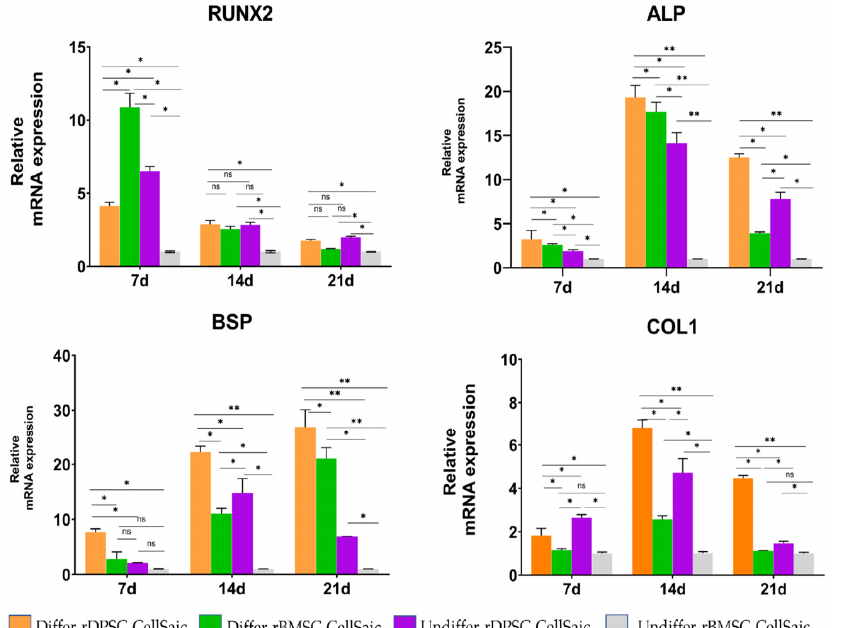
Figure 9. Expression of genes related to bone formation of rBMSC-CellSaic and rDPSC-CellSaic after culturing in normal and osteogenic differentiation media for 7, 14, and 21 days. Differ-rD-CellSaic and Differ-rB-CellSaic were osteogenic differentiation cultures; Undiffer-rD-CellSaic and Undiffer-rB-CellSaic were normal cultures (ns: no significance, * p < 0.05, ** p < 0.001).